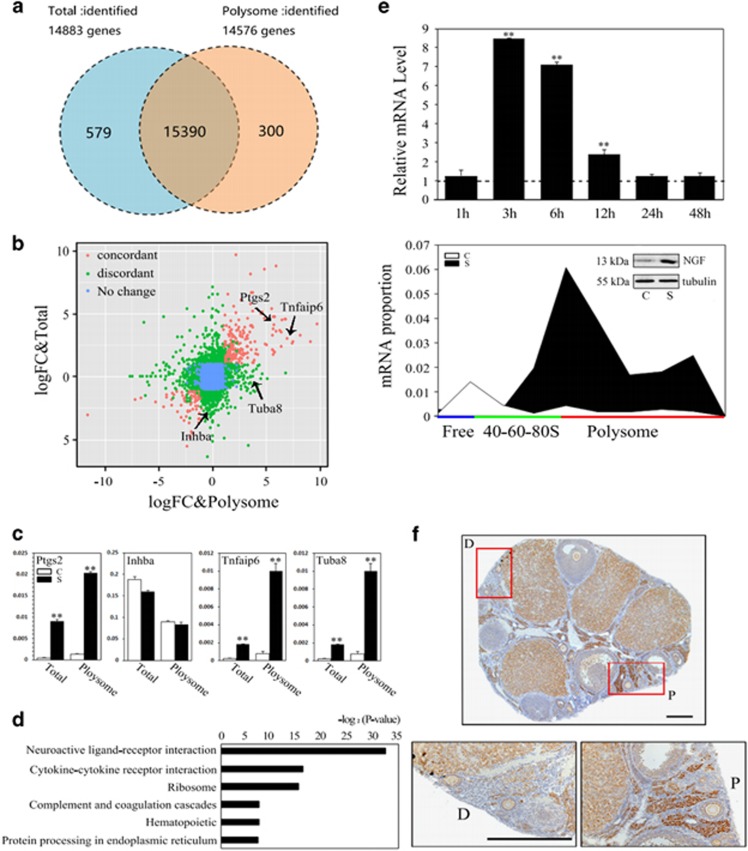
Post-transcriptional regulation of gene expression after ovarian surgery. Paired ovaries were collected at 6 h after surgery for total or polysome RNA-seq. C, control ovaries; S, surgically treated ovaries. (a) Venn diagram showing the overlap between genes detected in total and polysome RNA-seq. (b) LogFC (fold change) values from total and polysome samples were compared. The logFC values (S versus C) for the polysomal fraction (x axis) were plotted against the logFC values for the total fraction (y axis). The data points are colored according to the change in each fraction. Blue, genes that were not differentially expressed in each fraction; red, genes displaying changes in expression in both sets of conditions had high (or low) values of logFC (>1.0/<−1.0); green, differentially expressed genes either in the polysome fraction or in the total fraction. (c) Real-time RT-PCR validation of RNA-seq data randomly selected in each fraction. Data are displayed as means±S.E.M. **P<0.01, compared with control ovaries. (d) KEGG analysis of differentially expressed genes of polysome RNA-Seq (FDR<0.001). (e) Real-time RT-PCR was performed on the expression of Ngf in total (upper panel) and polysome-associated mRNAs (lower panel). Total mRNAs were collected at 1 h 3, 6 , 12, 24 or 48 h after ovarian surgery. Ovaries were collected at 6 h after surgery for polysome profiling. Fractions represented free RNA (blue, fractions 1–3), 40-60-80S (green, 4–11) and polysome (red, 12–25) were collected for RNA isolation and real-time PCR. Inset (lower panel), western blot of NGF protein expression and the expression of β-tubulin was used as internal control. (f) Differential expression of NGF in the proximal (P) and distal areas (D) of the incision 6 h after surgery (red frames). Lower, amplifications of P or D areas in red frames. Bar=100 μm